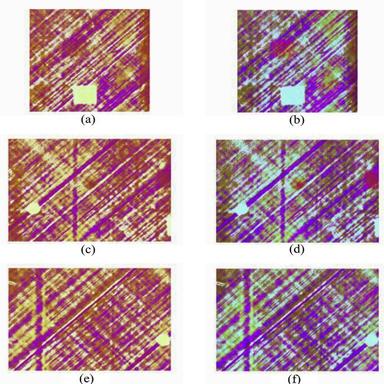
Images in false colors from the inspection of: (a)–(b) the training region and (c)–(f) of the test regions. Each RGB channel represents a feature of the exponential model before (left column) and after (right column) the FIR filter. (For interpretation of the references to color in this figure legend, the reader is referred to the Web version of this article.)